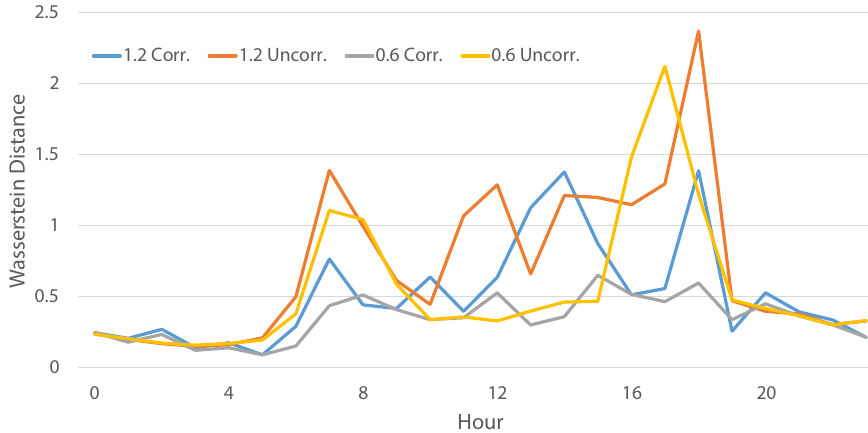
Figure 14. Shoulder normal hourly Wasserstein